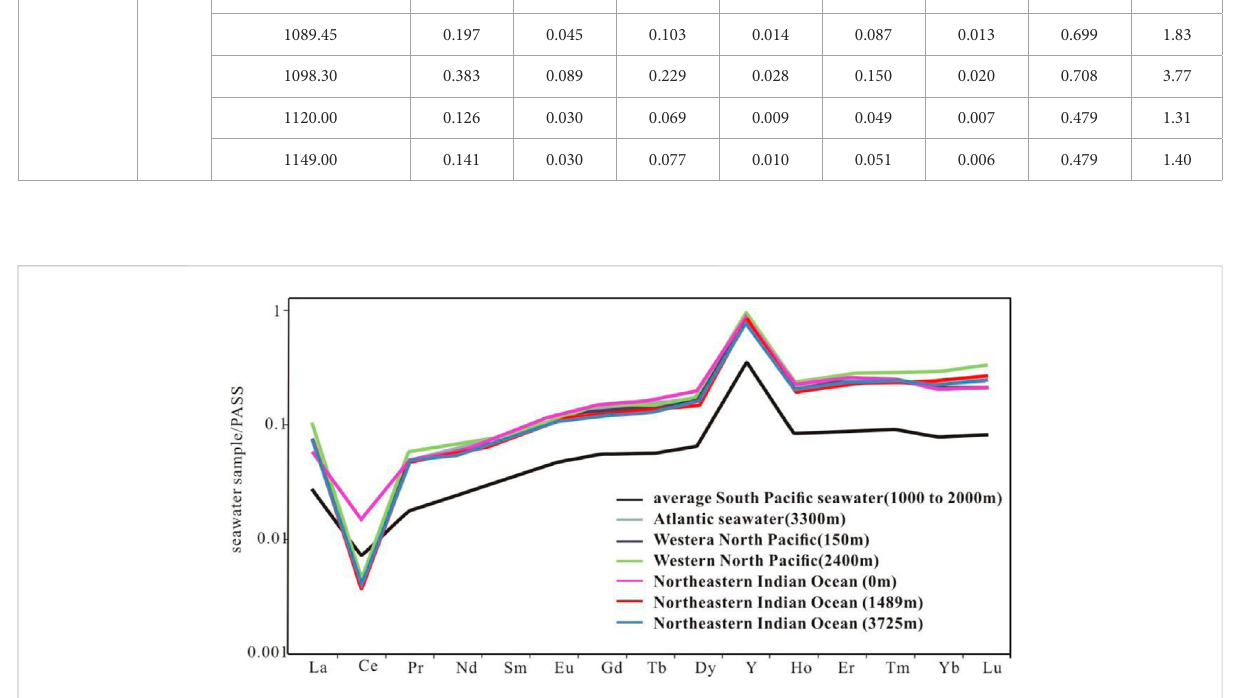
Distribution curves of REE in modern seawater (Wang et al., 2017; Wang et al., 2018).